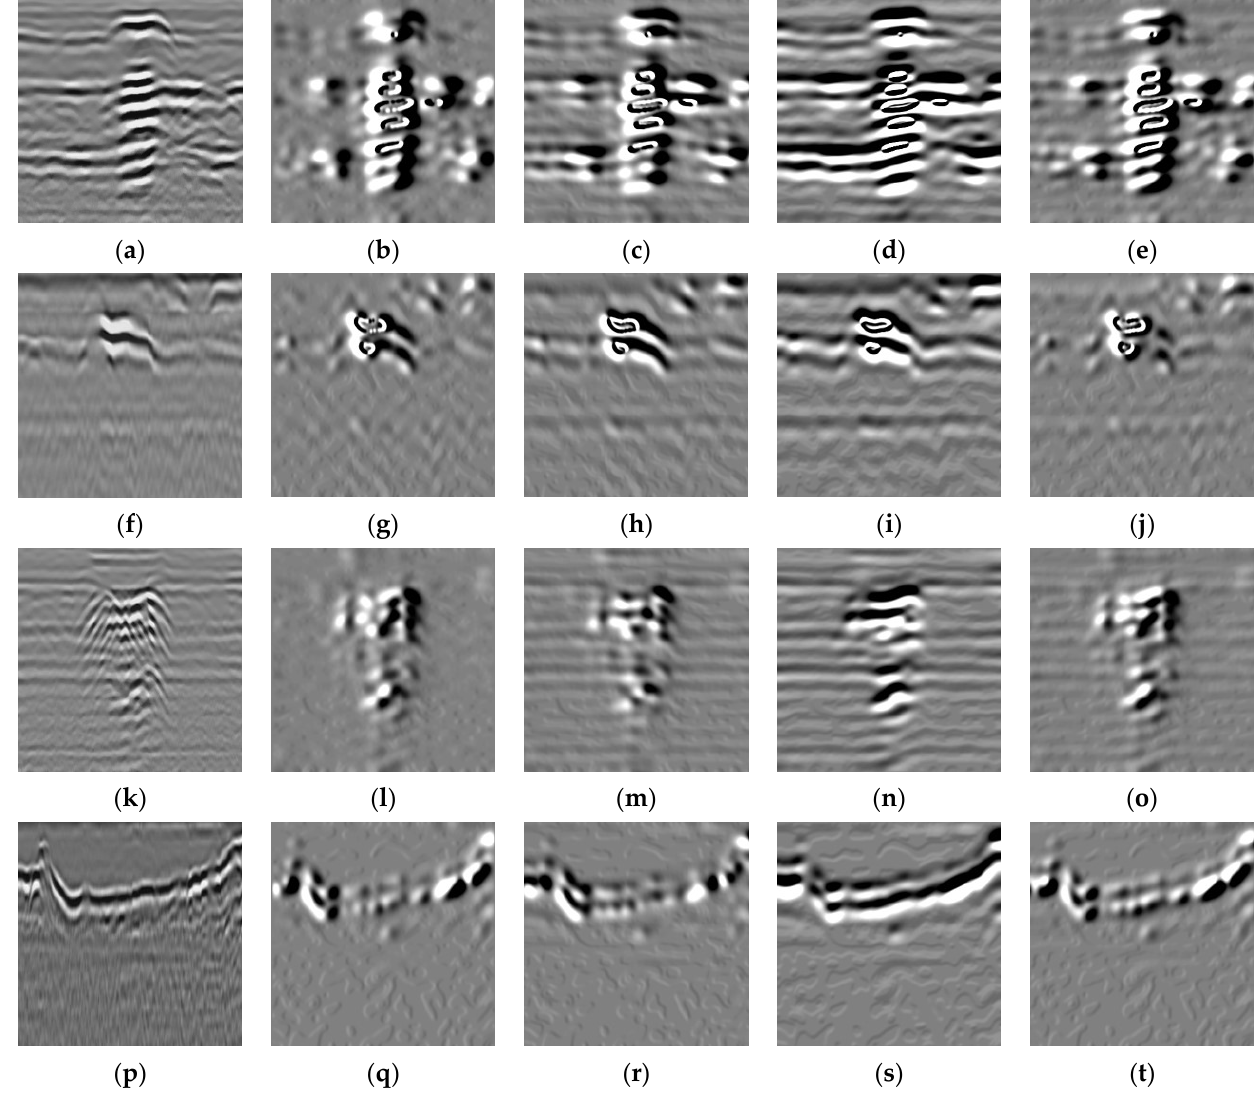
Figure 9. Partial image features comparison in different angles: ( a , f , k , p ) are filtered GPR image 1 to filtered GPR image 4; ( b , g , l , q ) are the 0° direction feature of image 1 to image 4; ( c , h , m , r ) are the 75° direction feature of image 1 to image 4; ( d , i , n , s ) are the 90° direction feature of image 1 to image 4; ( e , j , o , t ) are the 135° direction feature of image 1 to image 4.